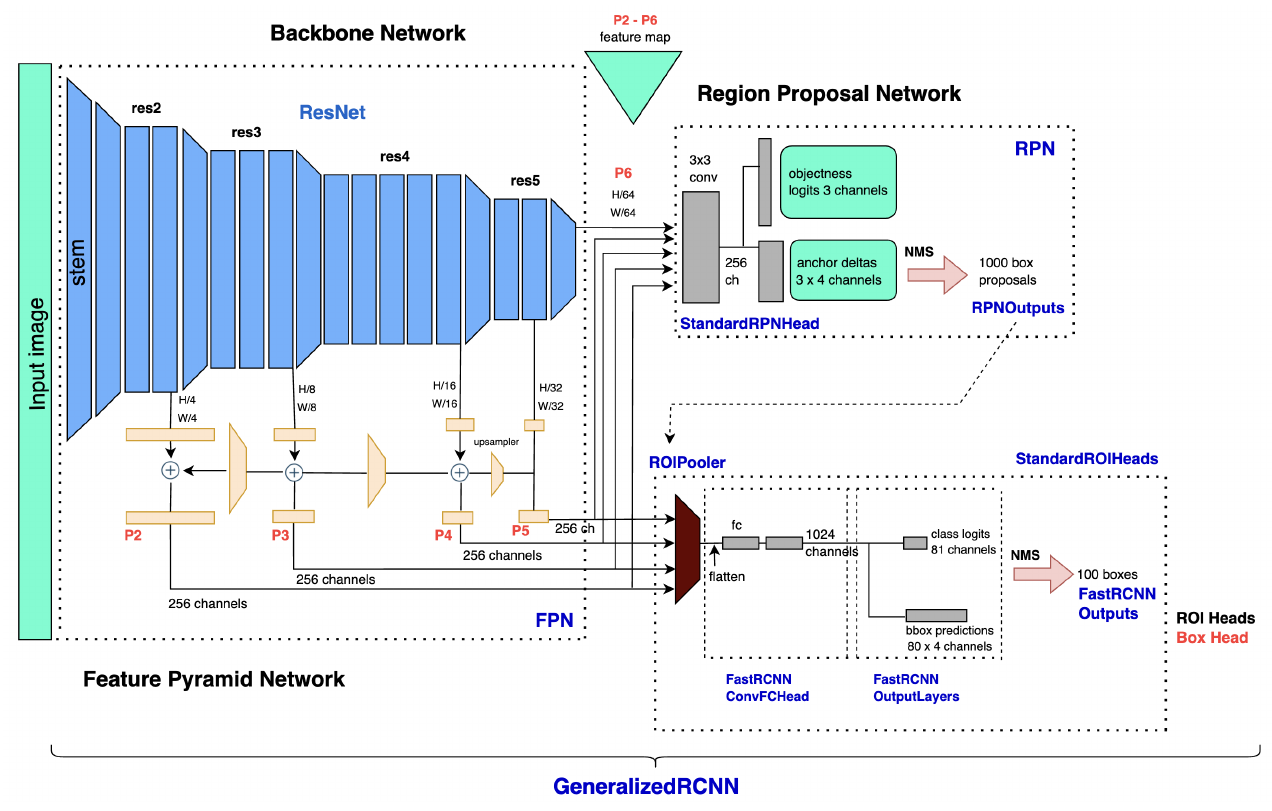
Figure 8. Detectron—Detailed Architecture of Base-RCNN-FPN